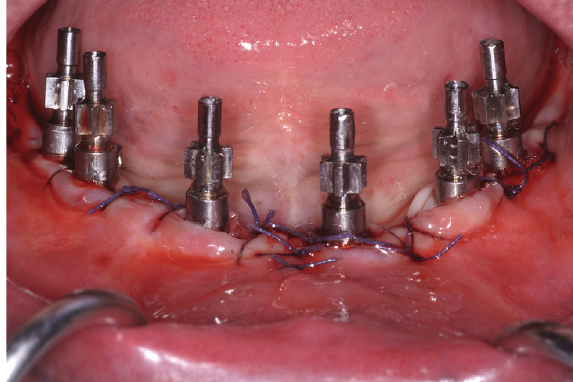
Figure 1: Impression transfer copings immediately after